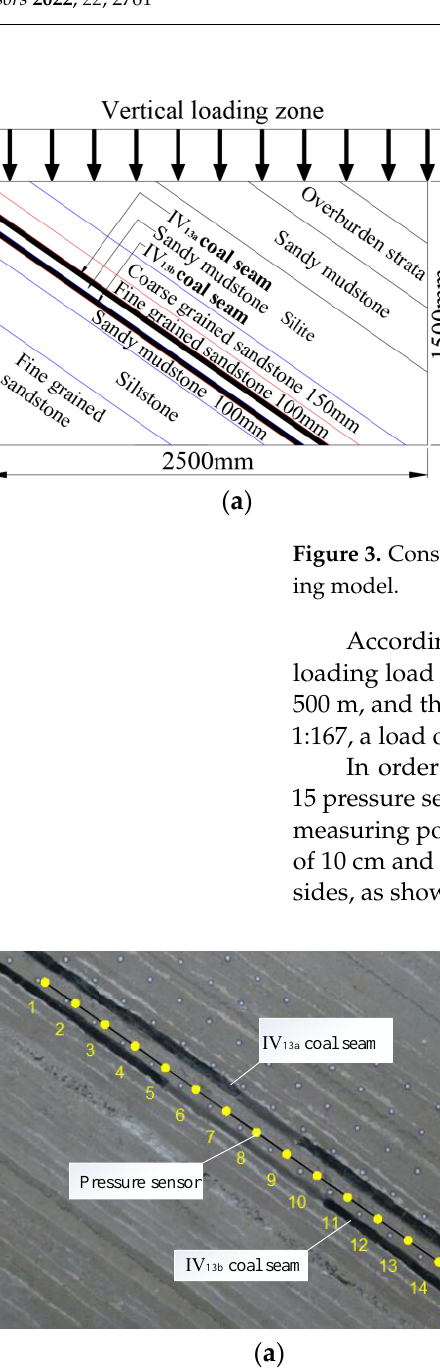
Figure 4. Layout of pressure sensor and measuring line. ( a ) pressure sensor layout; ( b ) schematic diagram of survey line.